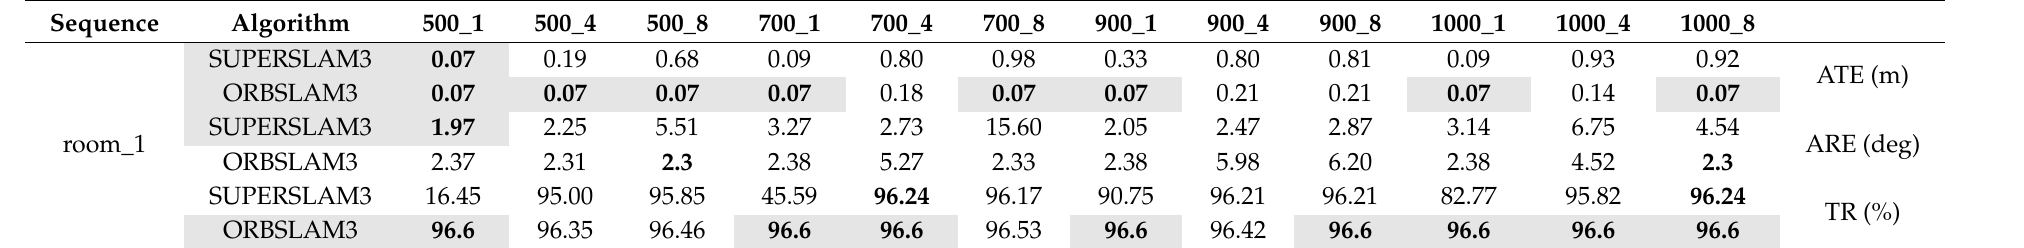
Table 3. Quantitative results on TUM-VI. For each sequence and for each performance metric, we highlight in bold the parameter configuration that attained the best result (for both ORBSLAM3 and SUPERSLAM3) individually for each analyzed metric (as described in the table’s right header). To indicate the one with the highest performance between the two, we color the corresponding cell and highlight the algorithm name in gray. In the table’s top header the parameters set are represented in the form ‘ nFeatures_nLevels